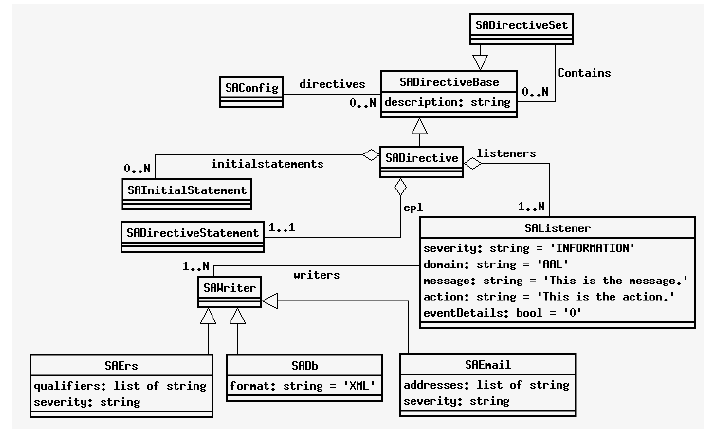
Figure 5. Object schema describing SA directives as part of a TDAQ configuration DB